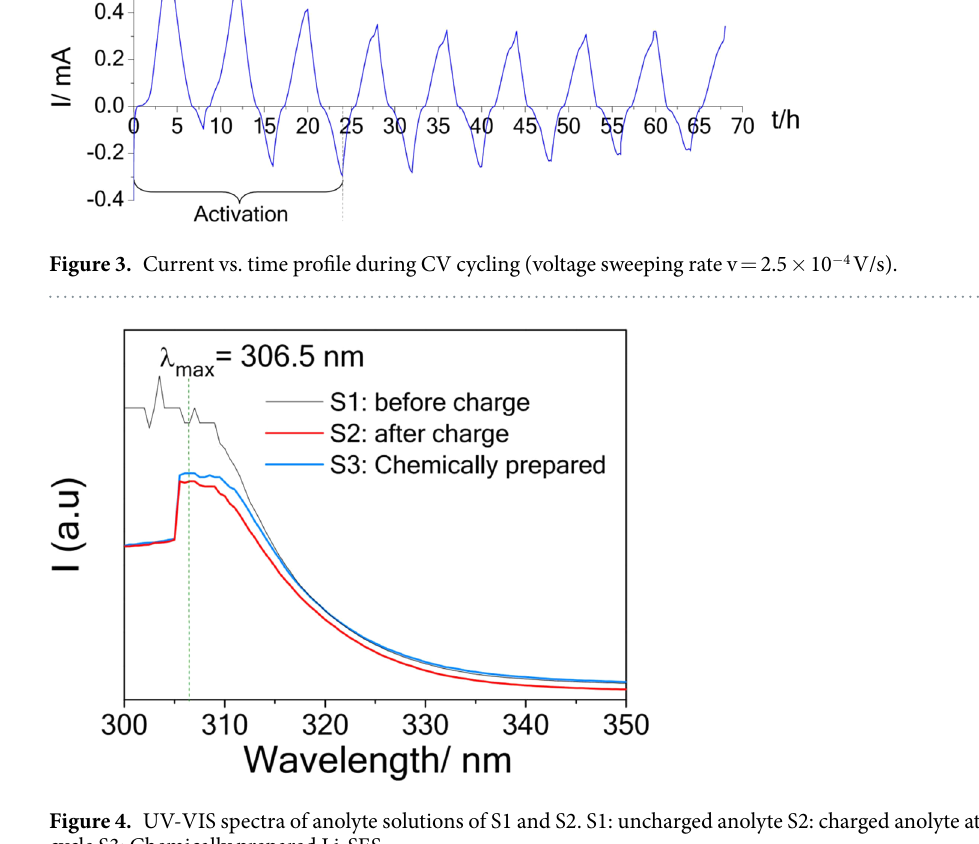
Figure 4. UV-VIS spectra of anolyte solutions of S1 and S2. S1: uncharged anolyte S2: charged anolyte at the 9 th cycle S3: Chemically prepared